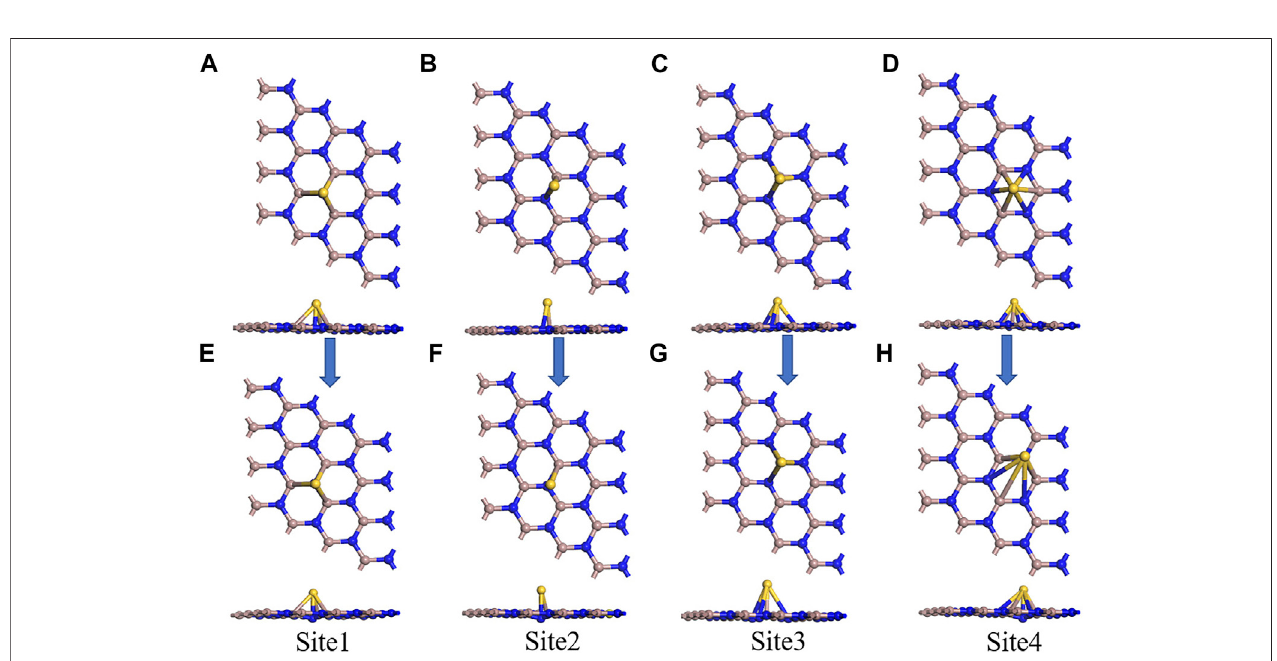
FIGURE3| FourinitialmodelsofAu-decoratedGaN. (A) Site1, (B) site2, (C) site3,and (D) site4.FouroptimizationmodelsofAu-decoratedGaN (E) Site1, (F) site 2, (G) site 3, and (H) site